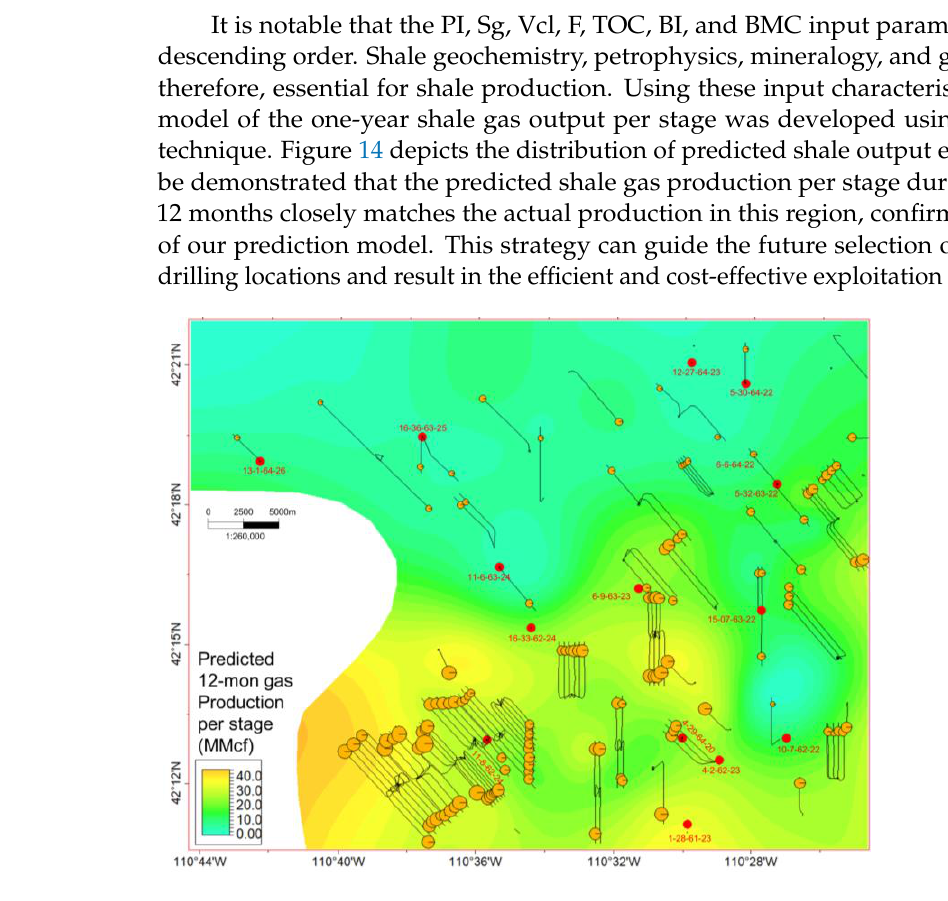
Figure 14. Prediction map of 12 mon gas production equivalence per stage via MLR approach in the studied region. The grey circle represents the actual one-year gas production equivalence per stage for horizontal wells, scaled by production values.